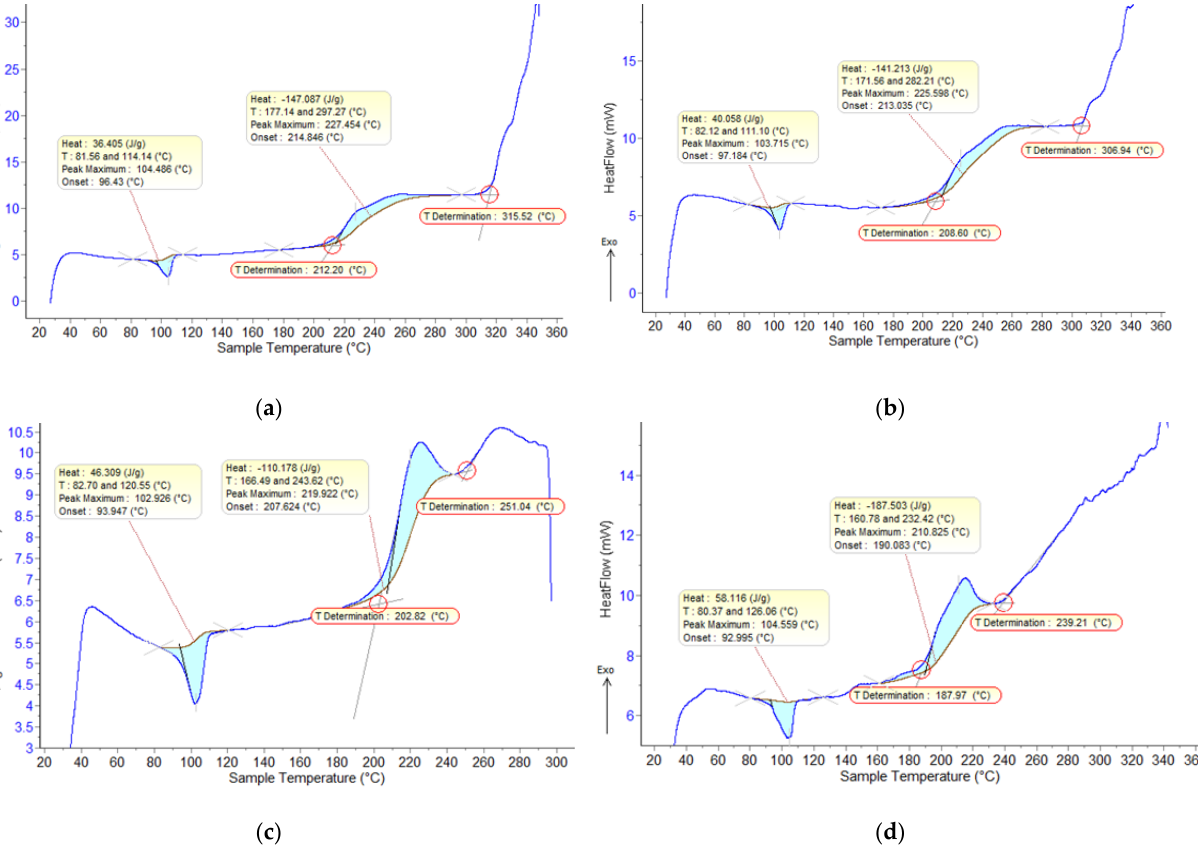
Figure 13. DSC characteristics (air, 10 °C/min), 7% mass ratio; ( a , b ) Al fillers in LDPE matrix—800 nm and 50 nm; ( c , d ) Fe fillers in LDPE matrix—800 nm and 50 nm and 50 nm; ( c , d ) Fe fillers in LDPE matrix—800 nm and 50